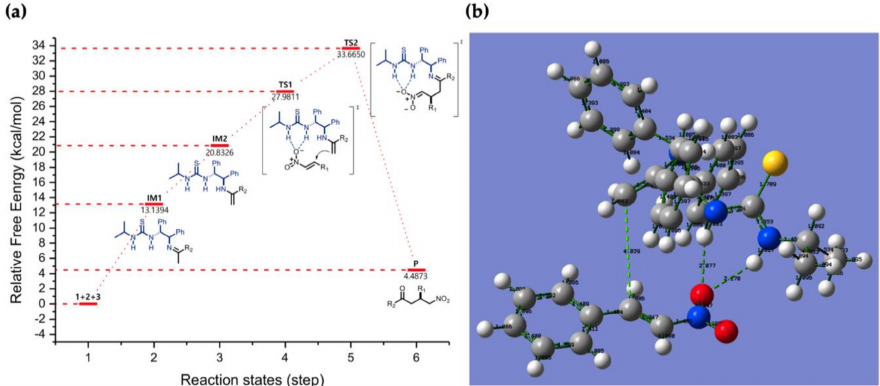
Figure 2. ( a ) Proposed catalytic mechanism. B3LYP / 6-31G(d,p) calculated free energy diagram of the ( R, R )-1,2-diphenylethylenediamine(DPEN)-thiourea-catalyzed enantioselective Michael reaction. ( b ) B3LYP / 6-31G(d,p)-calculated transi-tion state of the DPEN-thiourea-catalyzed enantioselective Michael reaction. Transition state structures for the C − C bond formation, through which the